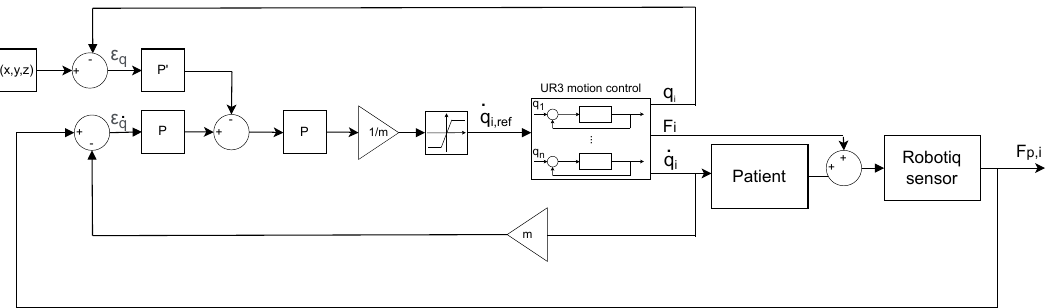
Figure 7. Control block diagram for active-assisted rehabilitation exercise in y and z axis for 2nd and 3rd